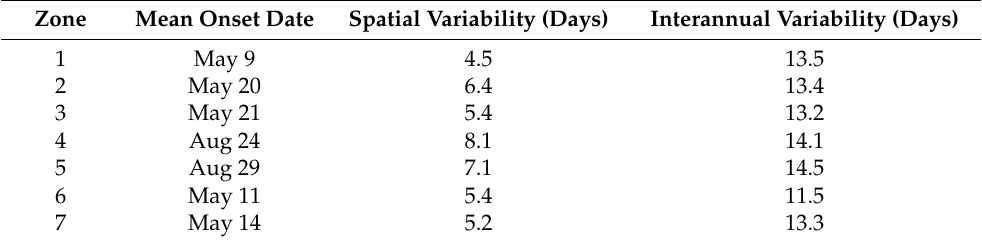
Table 1. Mean and variability (spatial and interannual) of zonal onset date for each agroclimatic zone.